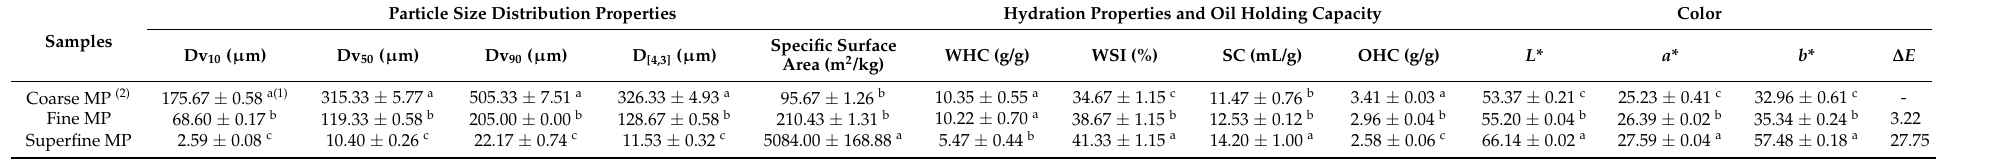
Table 2. Characterization of differently sized MP.